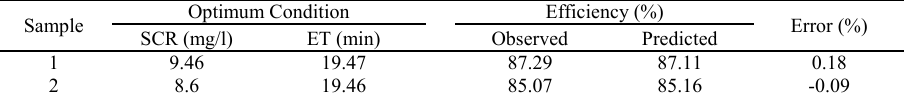
Table 8: Comparison of the efficiencies of experiments in the fitted model